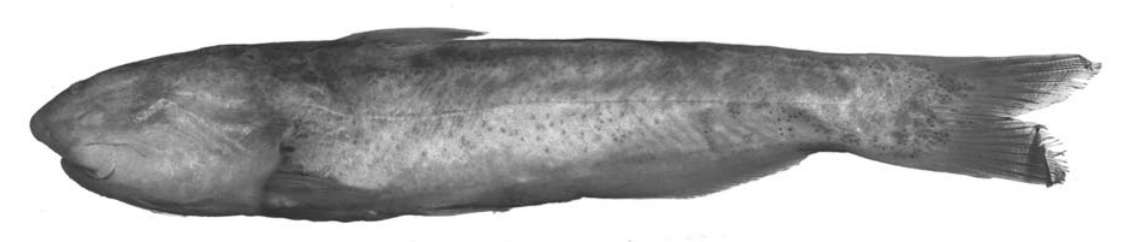
Fig. 15. Cetopsis caiapo , new species, holotype, MNRJ 13236, 69 mm SL; Brazil, Goiás, Município de Minaçu/Cavalcante, rio Tocantins, at location of the future dam of the Usina Hidroeléletrica Serra da Mesa (13°50’S,